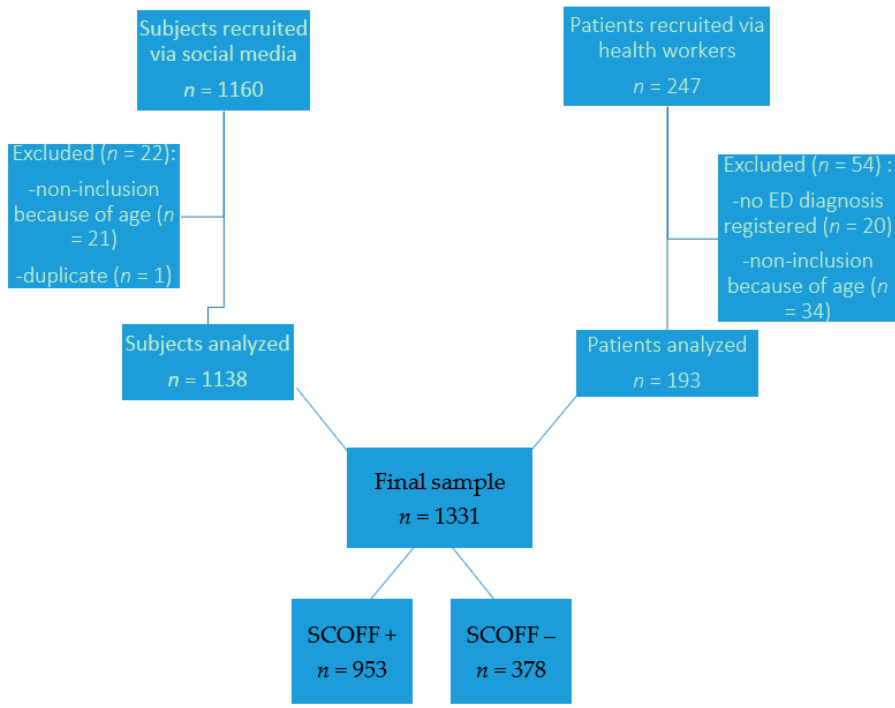
Figure 1. Flow chart of subjects’ inclusion.